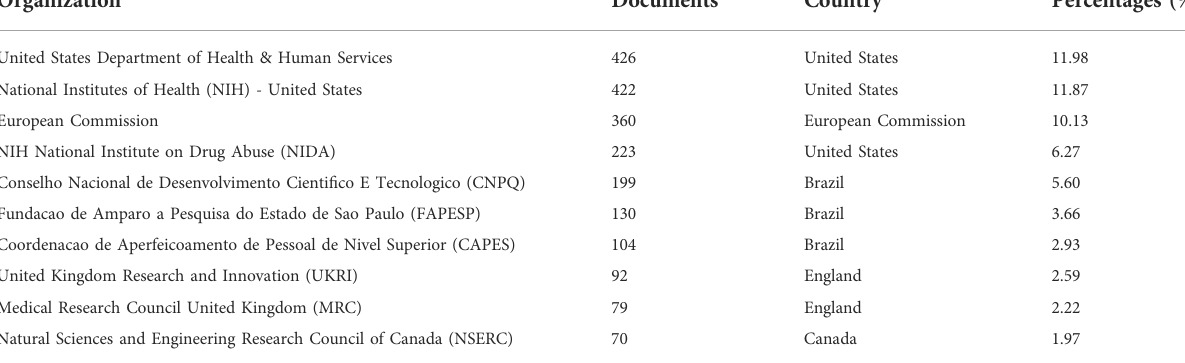
TABLE 2 The top 10 most productive funding agencies in the cannabidiol fi eld. Organization